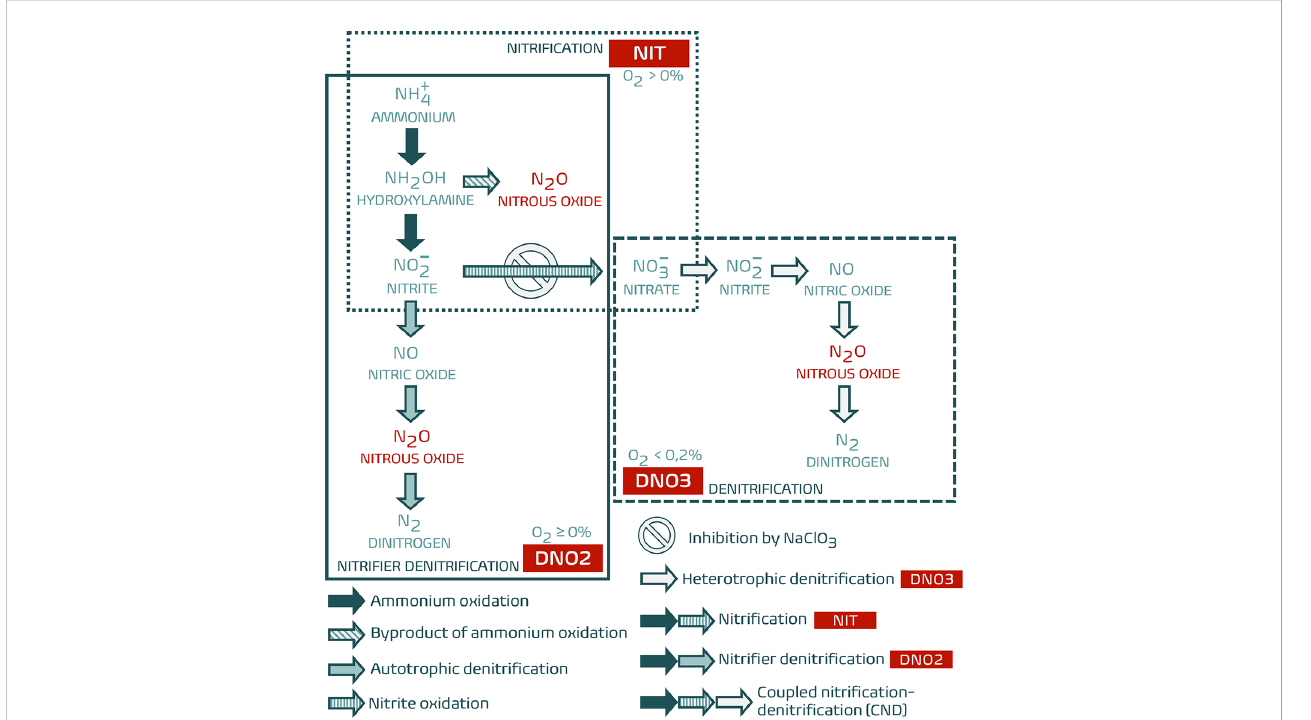
FIGURE 1 Relevant pathways in the marine nitrogen cycle with possible sources of N 2 O emission and oxygenation demands. The result of a targeted inhibition by NaClO 3 is indicated. NIT : oxic nitri fi cation (autotrophic); DNO2 : suboxic nitri fi er denitri fi cation (autotrophic); DNO3 : anoxic denitri fi cation (heterotrophic) coupled to nitri fi cation. Adapted from Zhu et al.